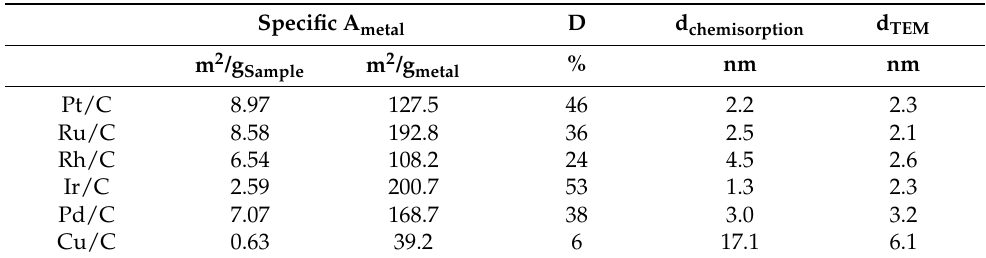
Table 3. Results of the H–chemisorption experiments. The stoichiometric factor of H*:M s chosen was 1. The data for Cu/C was determined by oxygen